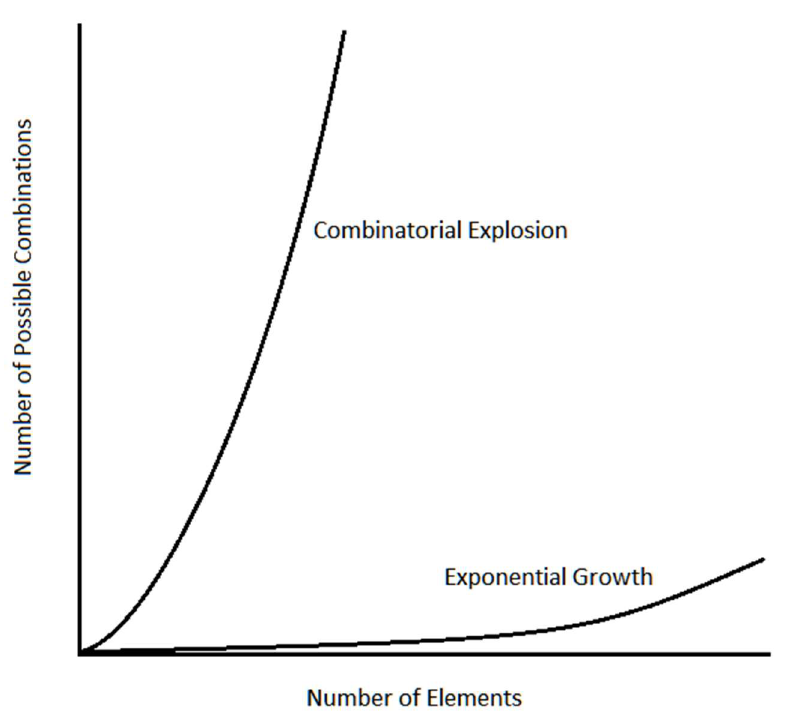
Figure 7. Plot of combinatorial explosion, the growth in number of possible combinations with respect to number of elements. For comparison, a plot of exponential growth is shown.